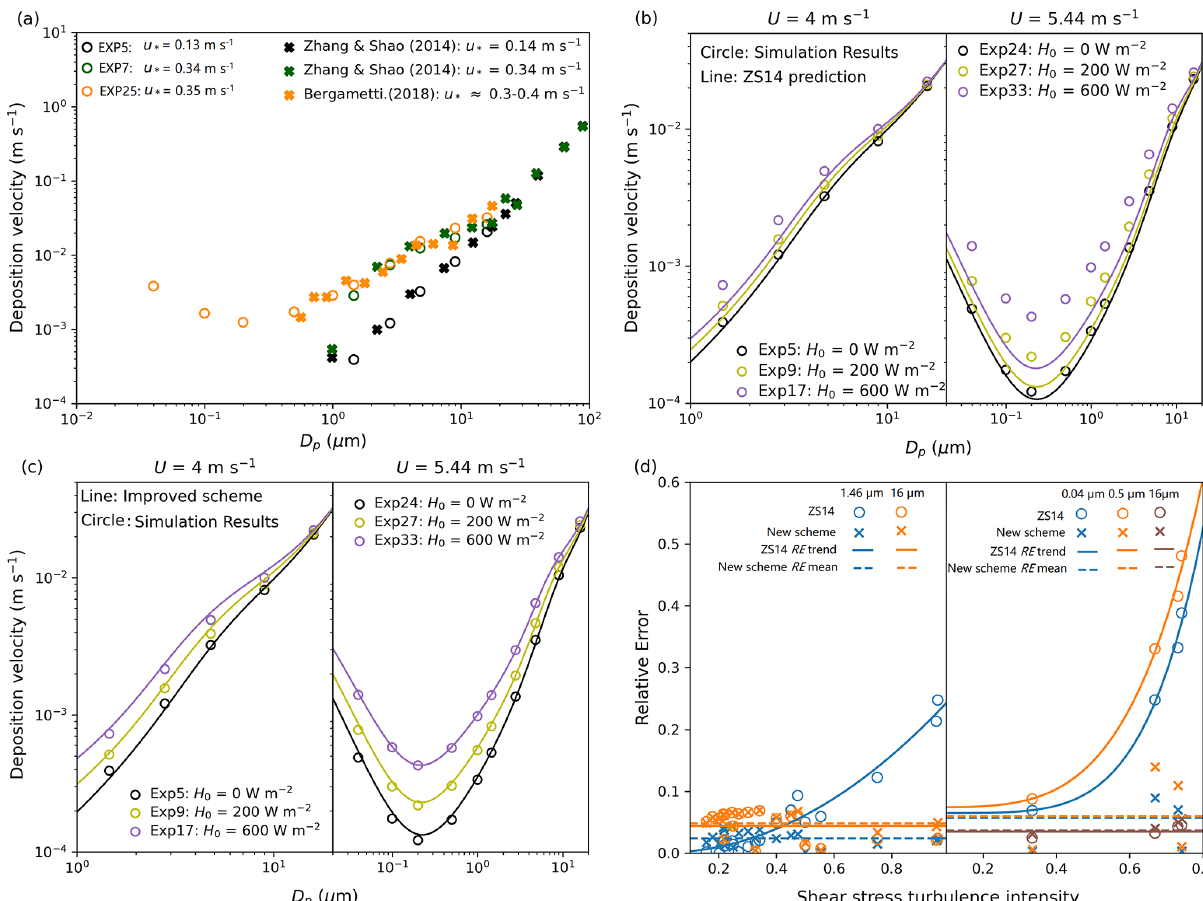
Figure 5. (a) Validation of the simulated deposition velocity from WRF-LES/D (circles) by comparing with the observation data (crosses). (b) The comparison of the predicted result by ZS14 scheme (lines) with the simulated value (circles) of Exp (5, 9, 17) (left) and Exp (24, 27, 33) (right). (c) The comparison of the predicted result by the improved scheme (lines) with the simulated value (circles) of Exp (5, 9, 17) (left) and Exp (24, 27, 33) (right). (d) Comparison of relative error as a function of shear stress turbulence intensity (TI-S), estimated by ZS14 scheme (circles) and the improved scheme (crosses) for Exp (1–20) (left) and Exp (24, 27, 30, 33)